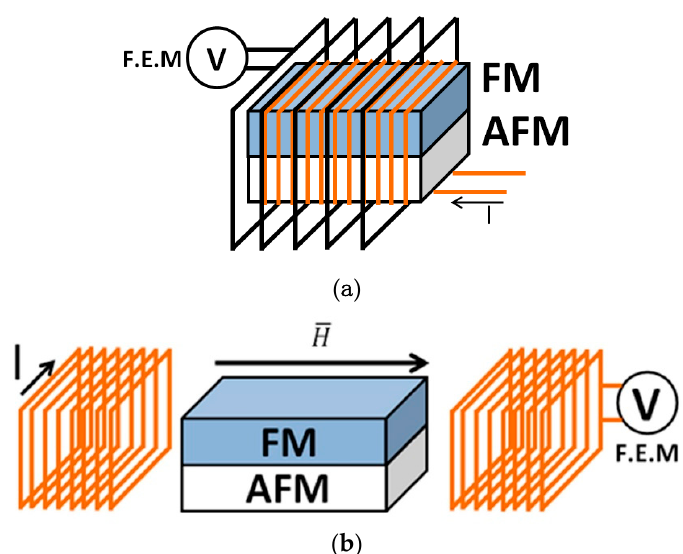
Figure 6. ( a ) Elemental EB device; ( b ) EB device with magnetic core (bilayer material) and separate field sensor.